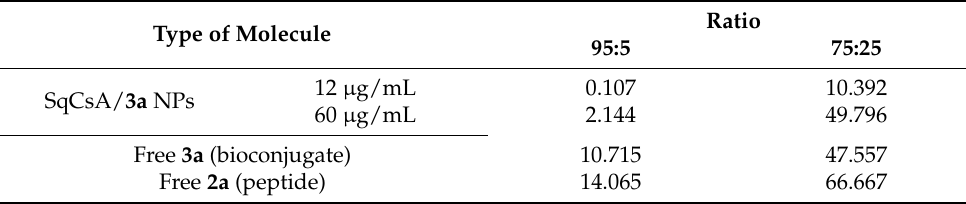
Table 2. Trolox equivalent (TE) of SqCsA/ 3a NPs, 3a bioconjugate and 2a peptide. Type of Molecule